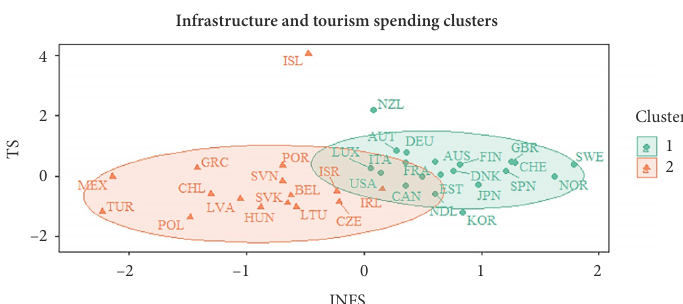
Figure 1. Cluster map for (1) infrastructure innovation indicators; (2) tourism spending indicators; (3) the link between infrastructure innovation and tourism spending